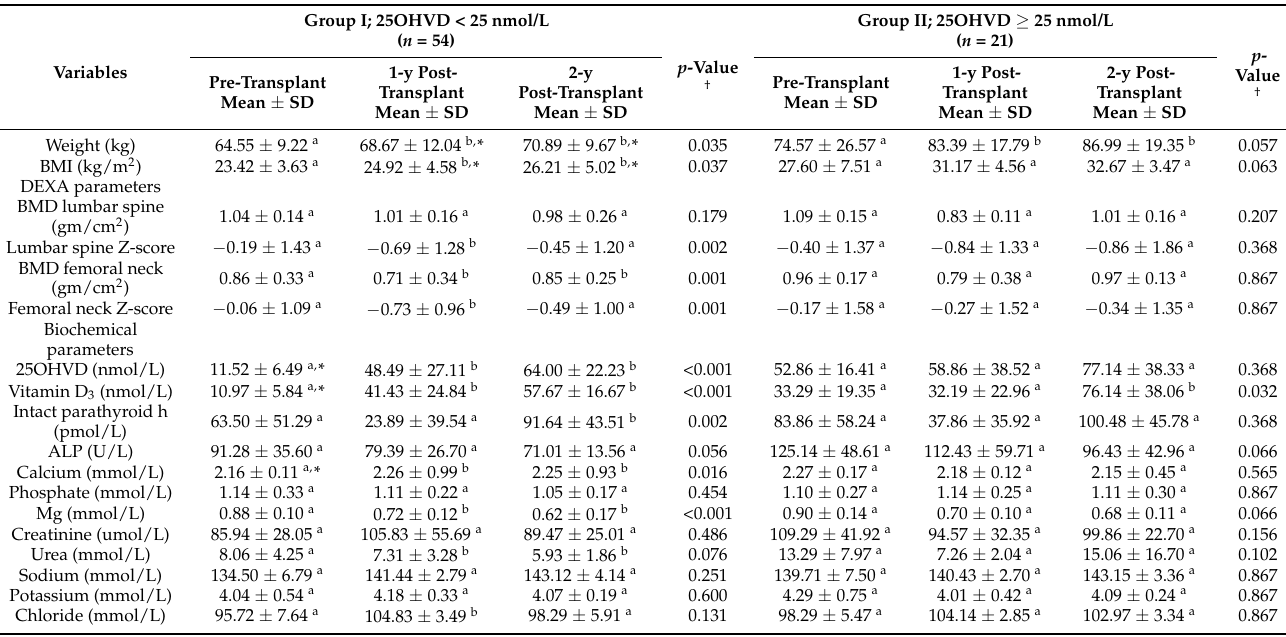
Table 3. Bone mineral density and related biochemical parameters before, 1 year, and 2 years after the heart transplant between study groups.